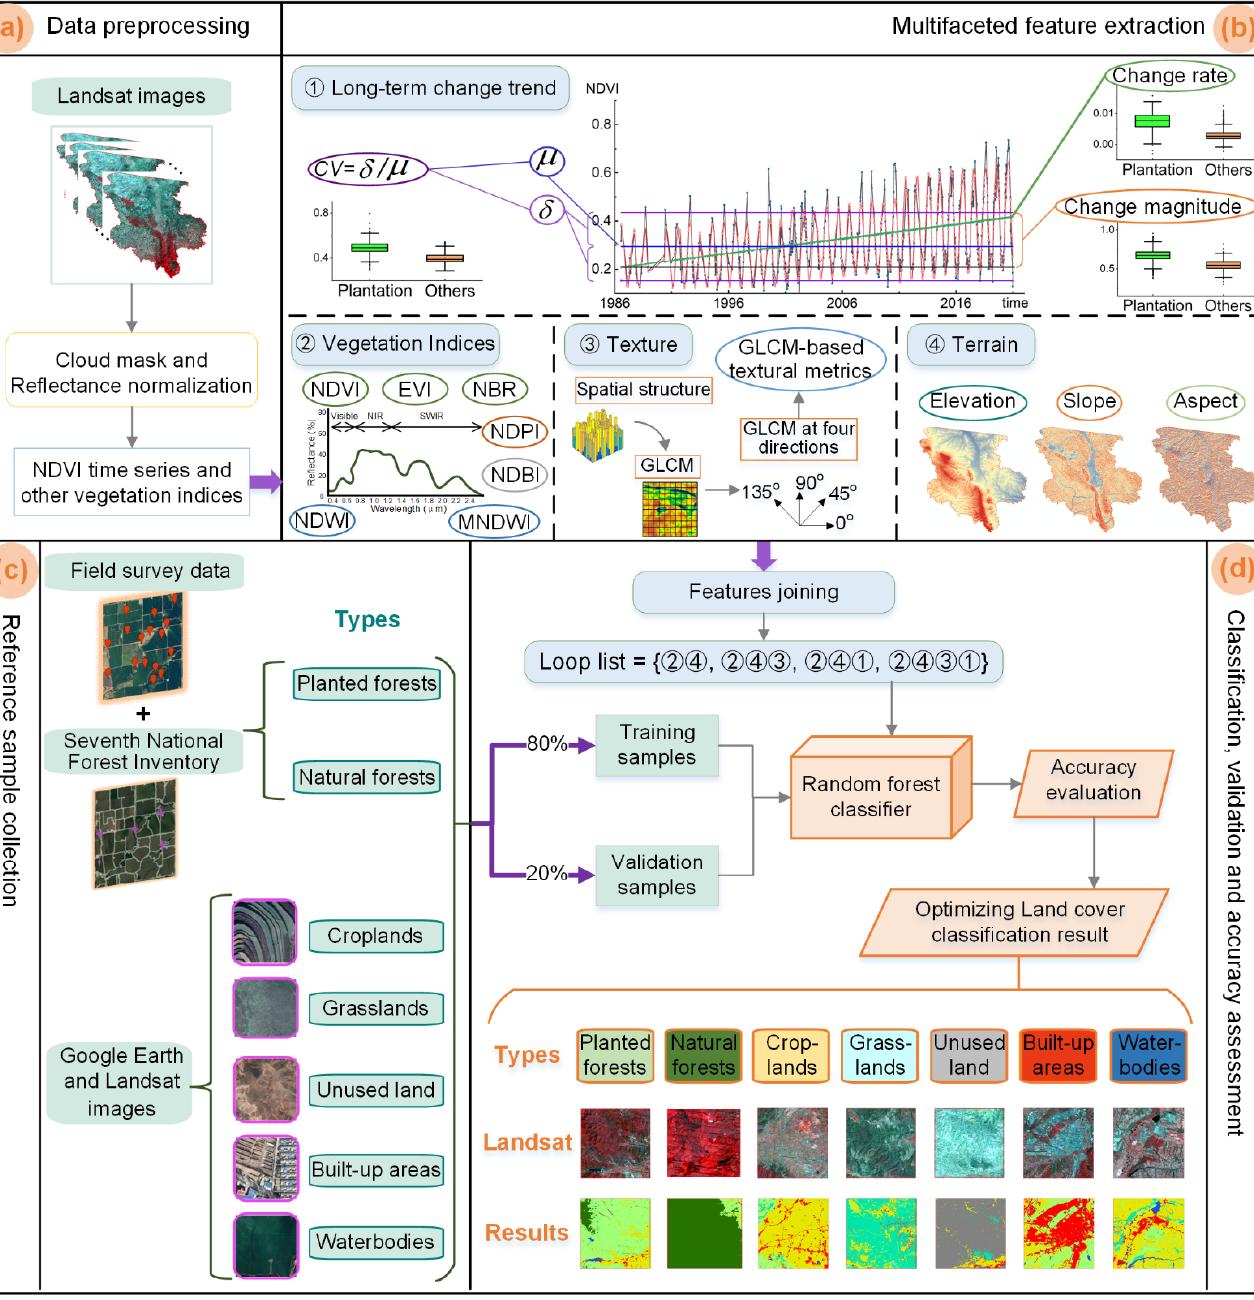
Figure 1. Framework for mapping the planted forests in this study: ( a ) data preprocessing, ( b ) multifaceted feature extraction, ( c ) reference sample collection, and ( d ) classification, validation and accuracy assessment. GLCM denotes the gray-level cooccurrence matrix, 𝜇 and 𝜎 denote the mean and standard deviation of the time series, and 𝑐𝑣 denotes the coefficient of variation of the time series. The various vegetation indices (VIs) are listed in Table A1 (Appendix A).